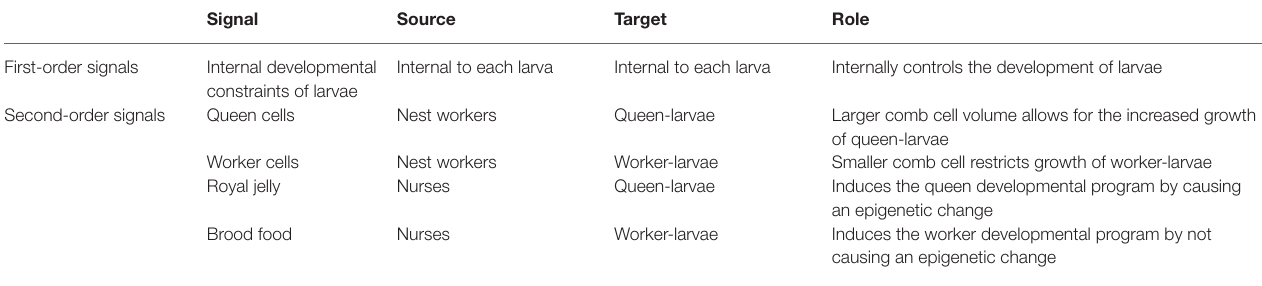
TABLE 2 | Queen/worker production in A.